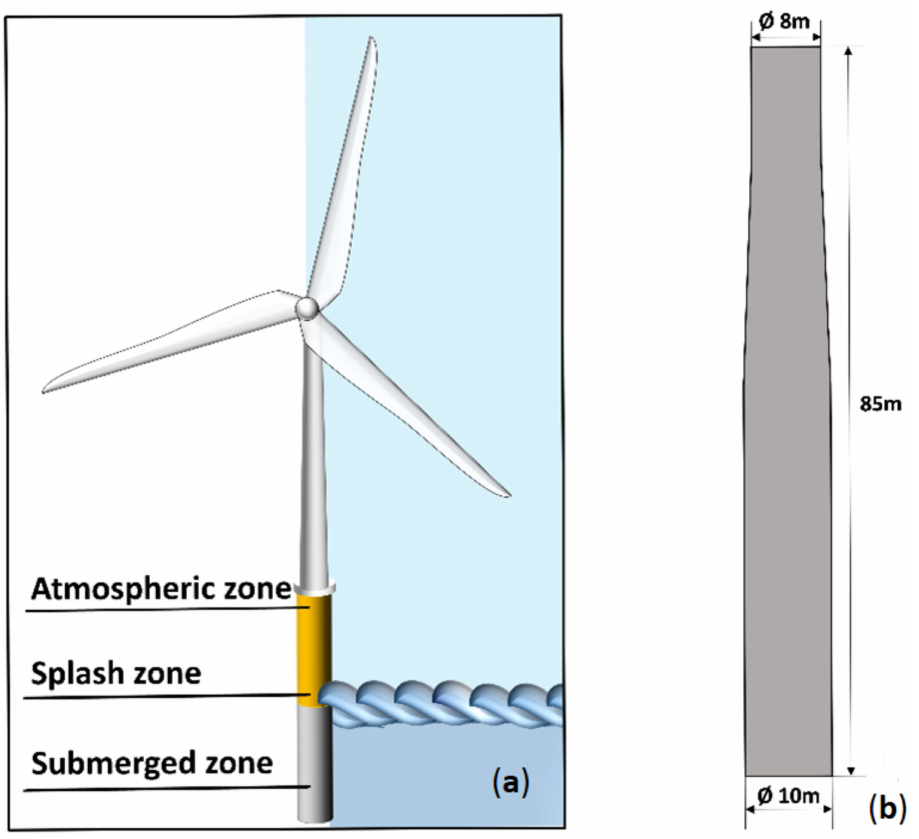
Figure 1. ( a ) Corrosion zones in an offshore wind generator. ( b ) Schematics and dimensions of the monopile considered in the